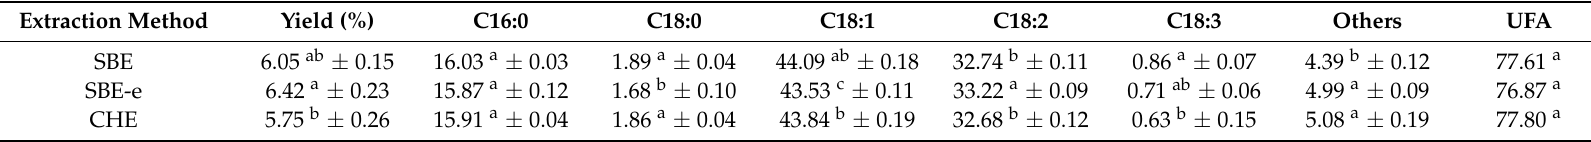
Table 3. Oil yield and fatty acid composition of OBO extracted by different